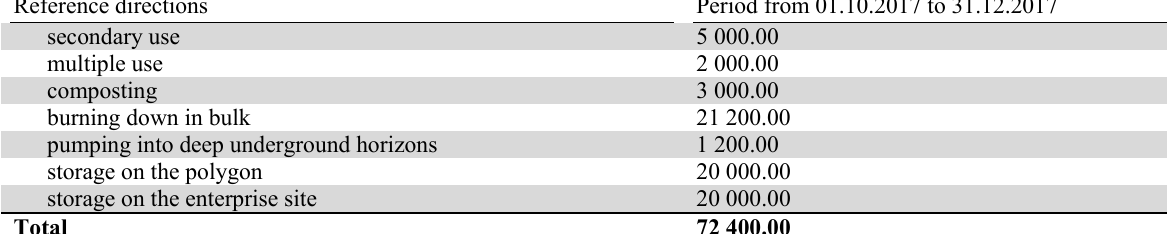
Non-financial accounting form “Report: Costs for acceptance, storage and disposal of hazardous wastes” Reference